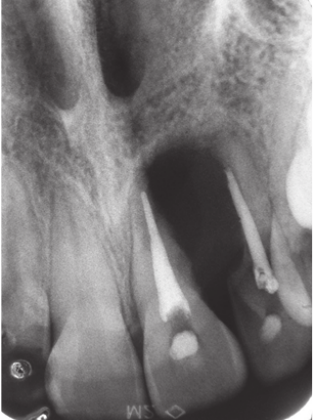
Figure 1: Periapical radiograph showing radiopaque image of the roots of teeth 21 and 22, which are compatible with root canal filling material, obtained from a radiolucent image of the blurred boundaries in the region of the upper